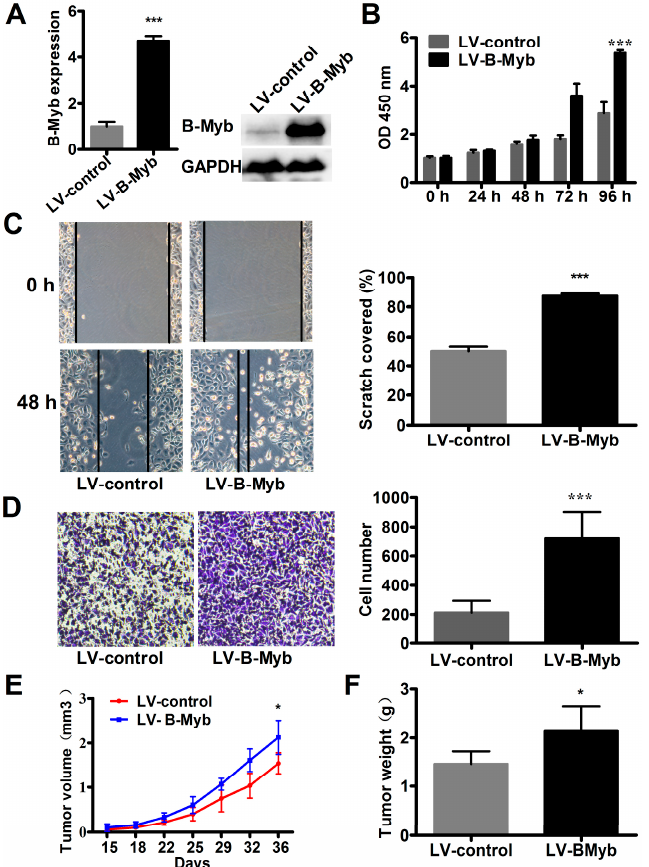
Figure 6. B-Myb overexpression promotes lung tumorigenesis in vitro and in vivo. ( A ) Lentivirus-mediated B-Myb overexpression. H1299 cells were infected with the control lentiviral particles and that led to expressing B-Myb, and then selected in the presence of puromycin to obtain the polyclonal control (LV-control) and B-Myb overexpression (LV-B-Myb) stable cells. Expression of B-Myb was examined by qRT-PCR and immunoblot analysis. ( B ) B-Myb increases cell proliferation. Cell proliferation was monitored by CCK8 assay in the stable control and B-Myb overexpression cells at the indicated time-points. ( C ) and ( D ) B-Myb augments cell motility. The stable control and B-Myb overexpression cells were seeded on six-well plates for the wound healing assay ( C ) and Transwell chamber for the Transwell migration assay ( D ), respectively.